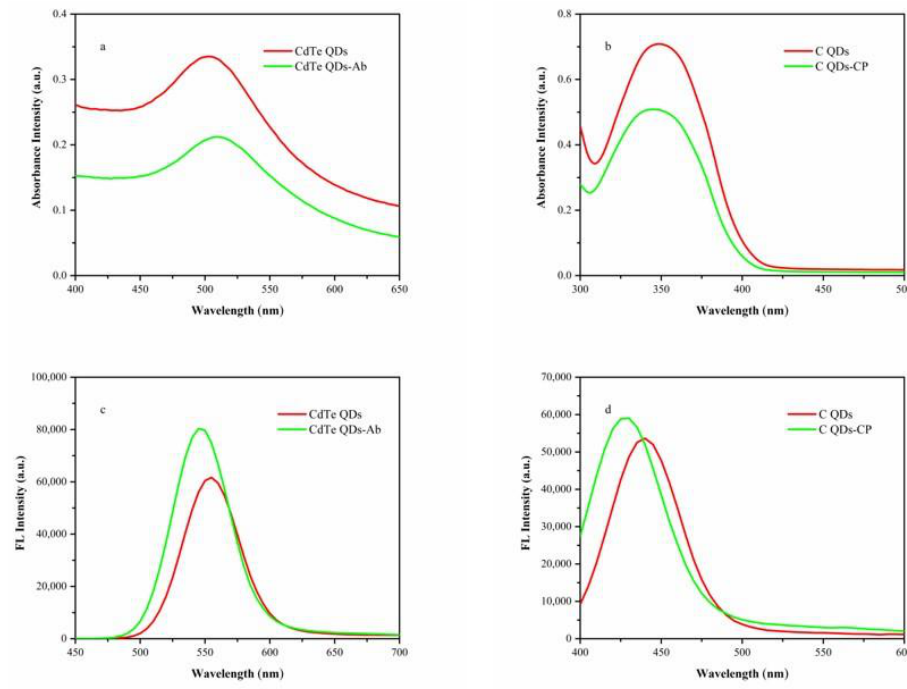
Figure 3. UV-Vis absorption spectra of CdTe QDs ( a ) and C QDs ( b ) before and after conjugation. Fluorescence spectra of CdTe QDs ( c ) and C QDs ( d ) before and after conjugation.